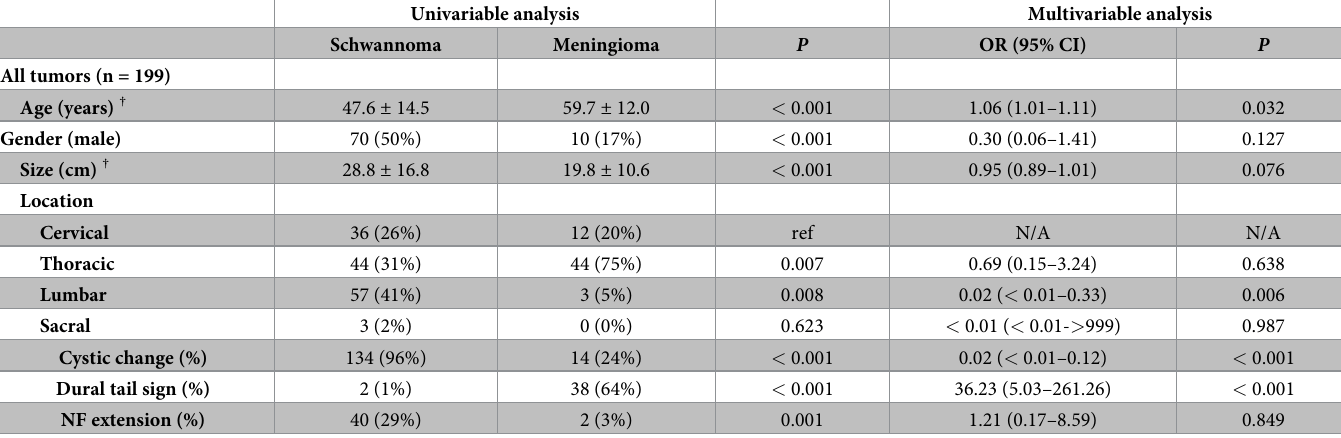
Table 1. Comparison of clinical and MRI parameters in differentiating between schwannoma and meningioma groups.